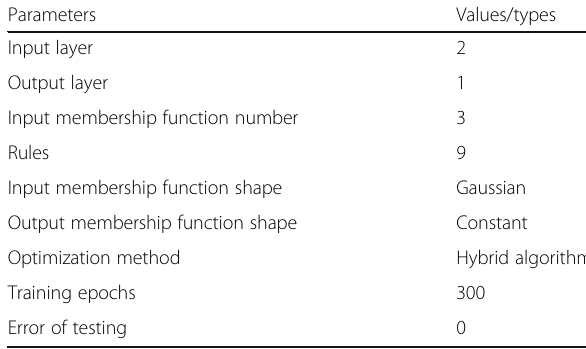
Table 1 Parameters of each ANFIS